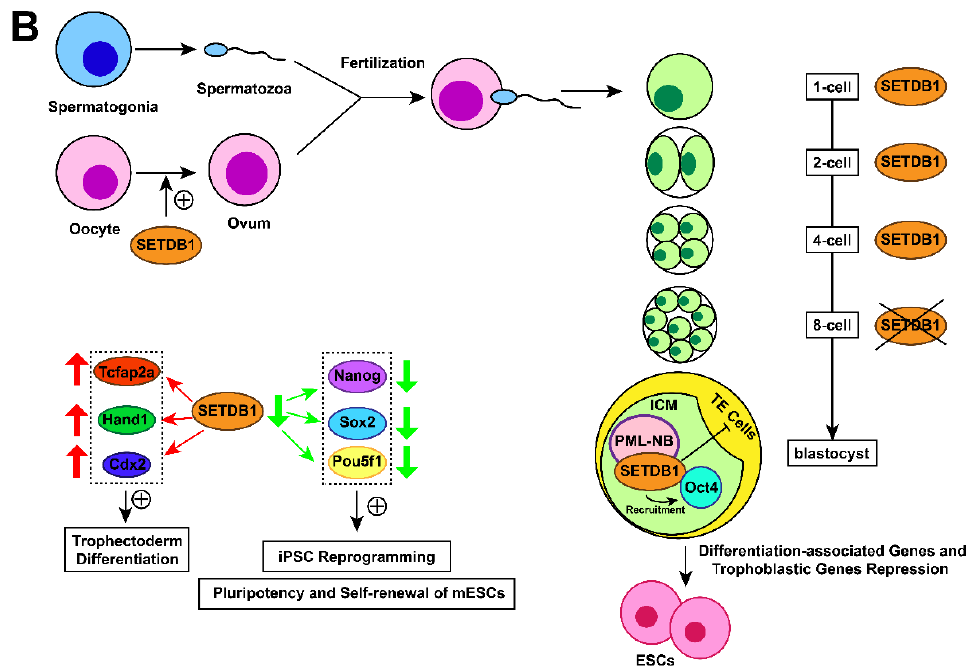
Figure 1. Action mechanisms and the subsequent functions of SETDB1 with its cofactors. ( A ) Together with H3K9 trimethylation on specific gene locus, the formation of SETDB1-KRAB-KAP1, SETDB1-DNMT3A, SETDB1-PML, SETDB1-ATF7IP-MBD1 complexes play crucial roles in the processes of histone methylation, chromatin remodelling and transcriptional suppression, which leads to corresponding physiological functions, including ERVs silencing, XCI and tumour-suppressive genes repression. ( B ) SETDB1 exerts different roles during the preimplantation stage due to its varying expression patterns. It maintains the pluripotency of mESCs by repressing differentiation-associated and trophoblastic genes while facilitating self-renewal by positively regulating the genes associated with iPSC reprogramming and self-renewal.